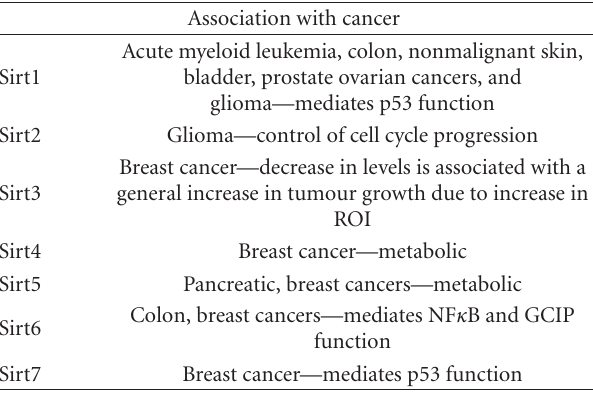
Table 2: Cancers associated with Sirtuins and their proposed mechanism of